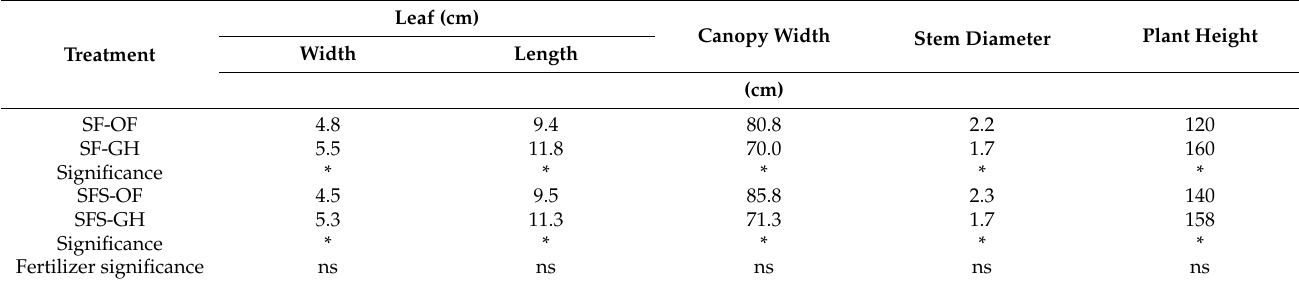
Table 6. Vegetative growth as affected by starfish (SF)- and starfish + seaweed (SFS)-liquid fertilizers applied in open-field (OF) and greenhouse (GH) cultivated red peppers.